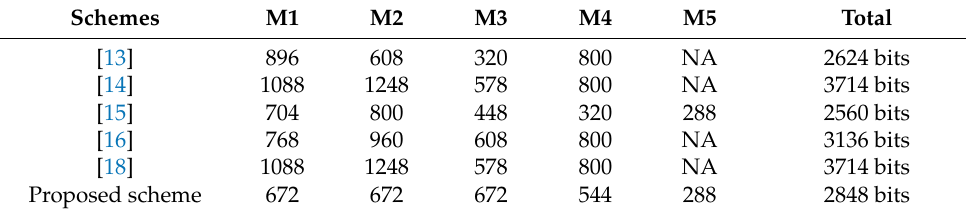
Table 11. Intercommunication cost